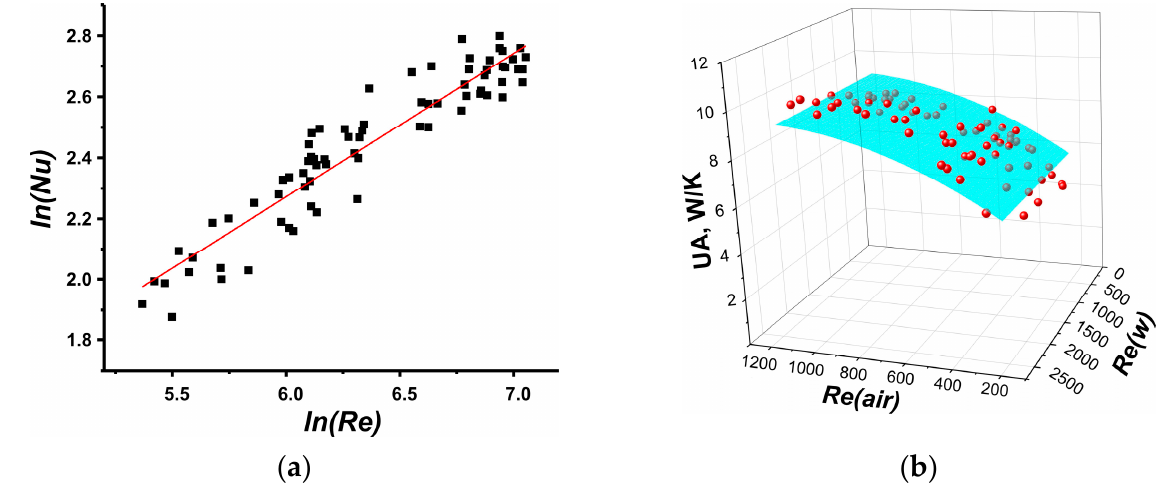
Figure 7. ( a ) Nu number correlation for radiator R1; ( b ) Comparison of experimental data (red symbols) and approximation (blue 3D surface) calculated by found correlation.